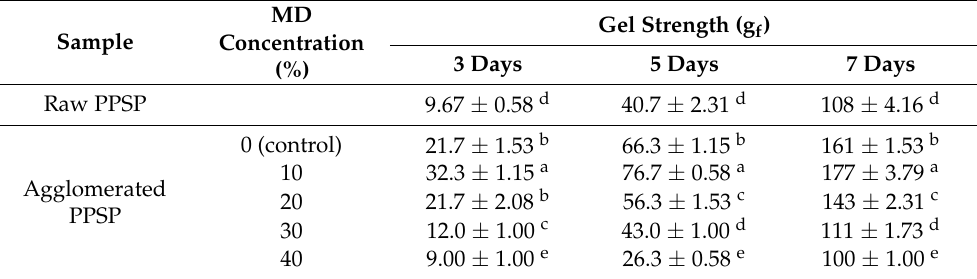
Table 3. Gel strength of raw and agglomerated PPSPs with different concentrations of MD binder over storage